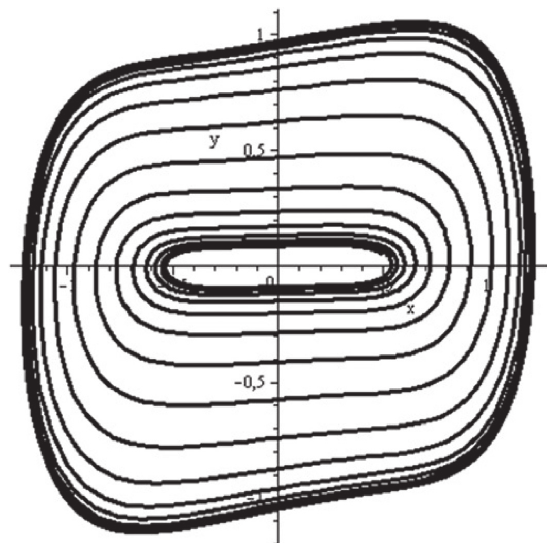
Figure 1: Limit cycles for the system in Example 1 with ϵ � 0 .